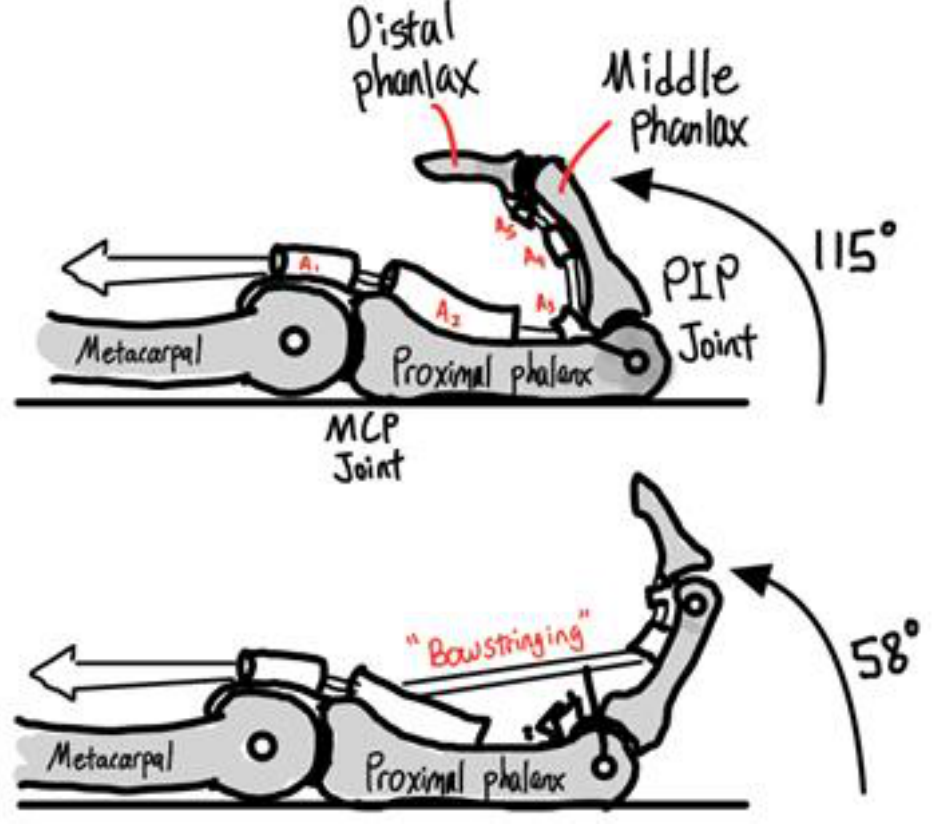
Figure 5. Finger pulleys’ position and usage.